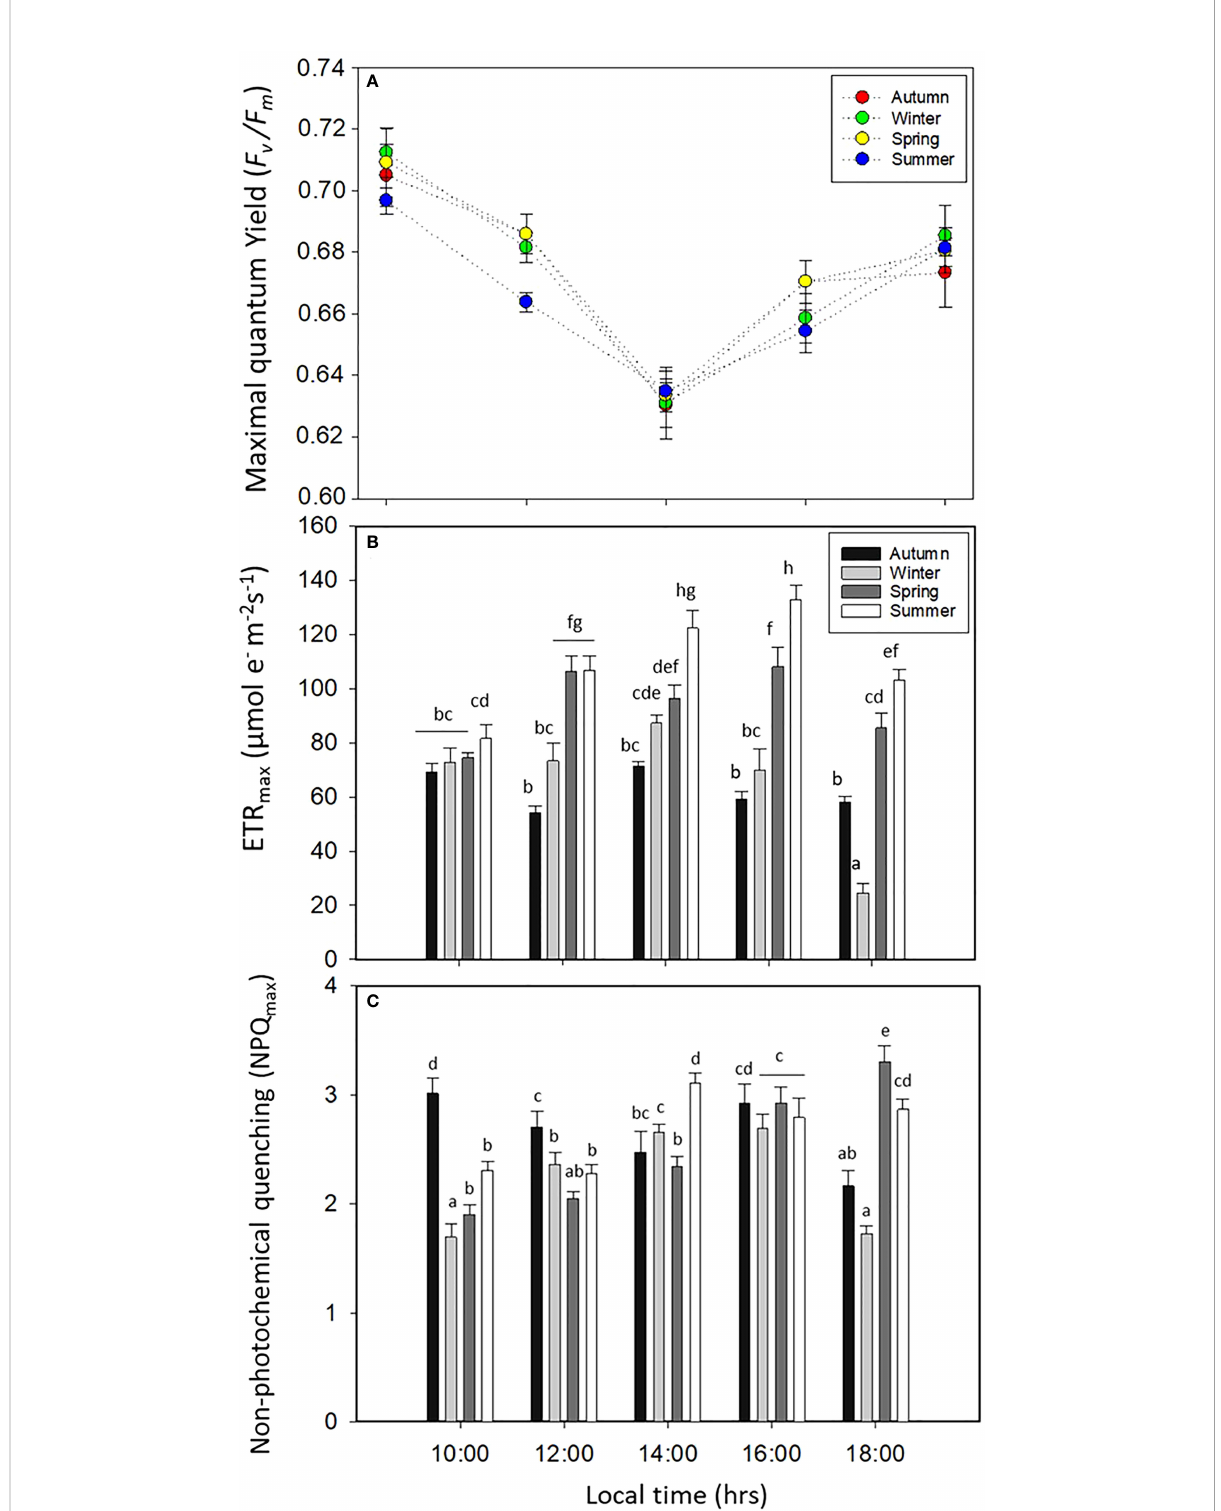
FIGURE 4 (A) Maximal quantum yield ( F v / F m ), (B) maximal electron transport rate (ETR max ), and (C) non-photochemical quenching (NPQ max ) in Lessonia spicata during the daily cycle experiments in autumn, winter, spring, and summer between 2019 and 2020 in Valpara ı ́ so Bay. Lower - case letters denote signi fi cant after the SNK